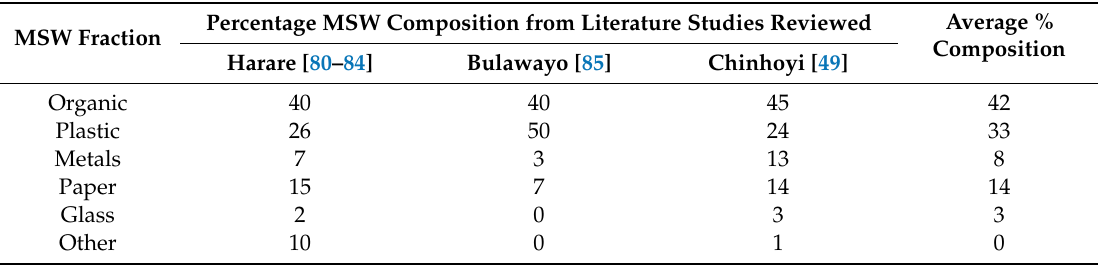
Table 3. Estimates of percentage composition of MSW generated in